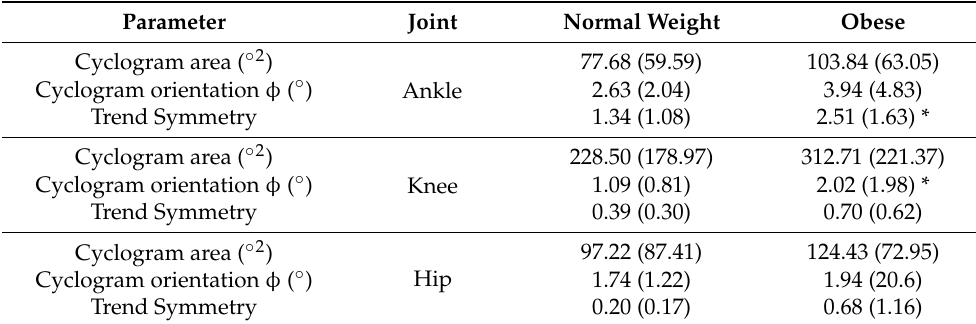
Table 4. Comparison between interlimb symmetry parameters of gait of normal weight and obese individuals. Values are expressed as mean (SD). Parameter Joint